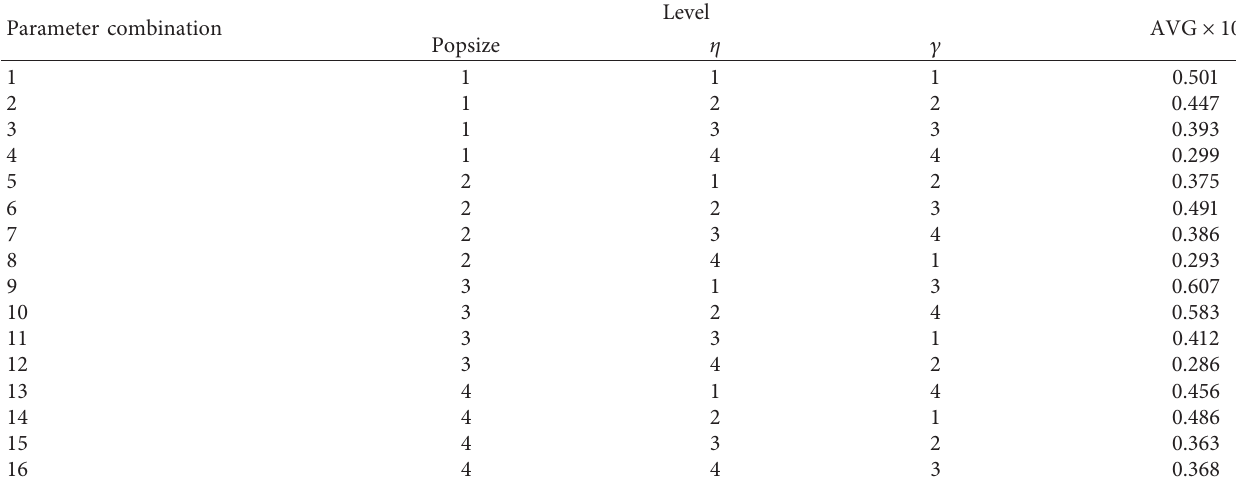
Table 2: Orthogonal table and average statistics.